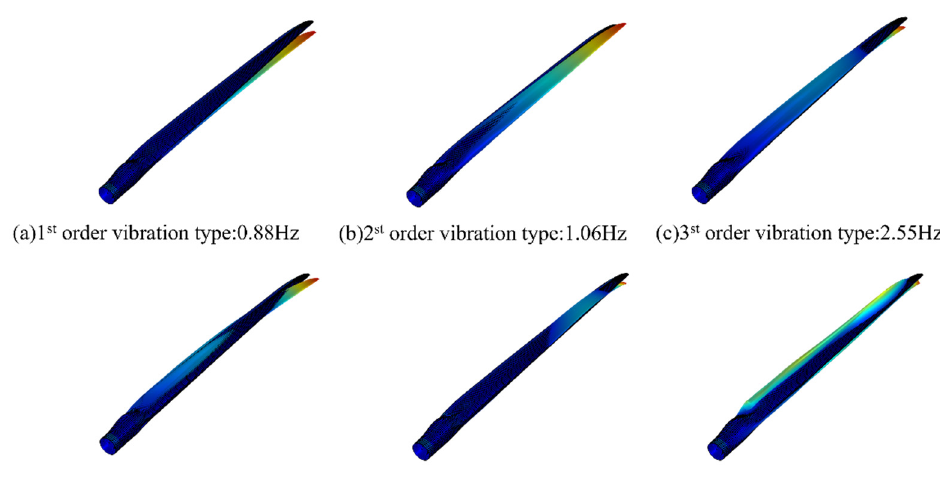
Figure 9. Vibration type of wind turbine blade after optimization.